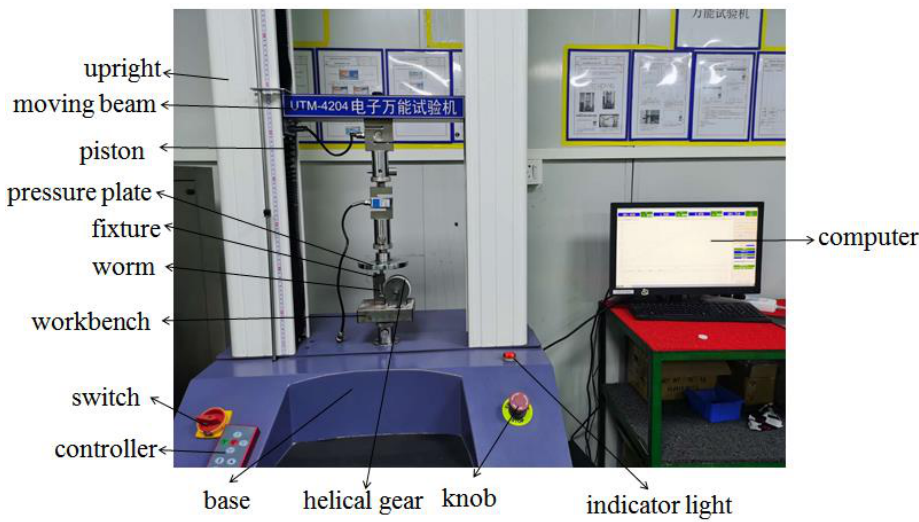
Figure 15. Test Figure 15. Test machine.